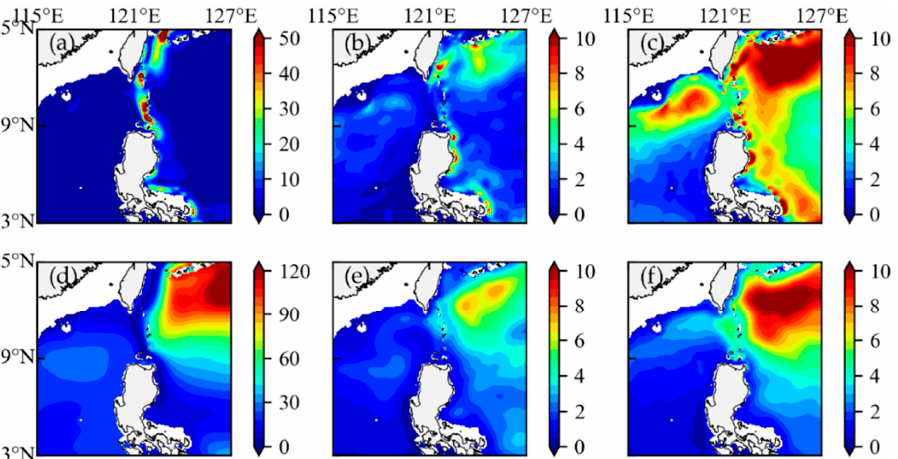
Figure 7. Temporally (1996–2015) and vertically (lower 266 m) averaged multiscale KE and APE components (Jm − 3 ). ( a ) CKE; ( b ) SKE; ( c ) EKE; ( d ) CAPE; ( e ) SAPE; ( f ) EAPE. At the end of this section, the vertical structures of six energy components are dis- played in Figure 8. Overall, the kinetic energy at each scale decays rapidly with increasing